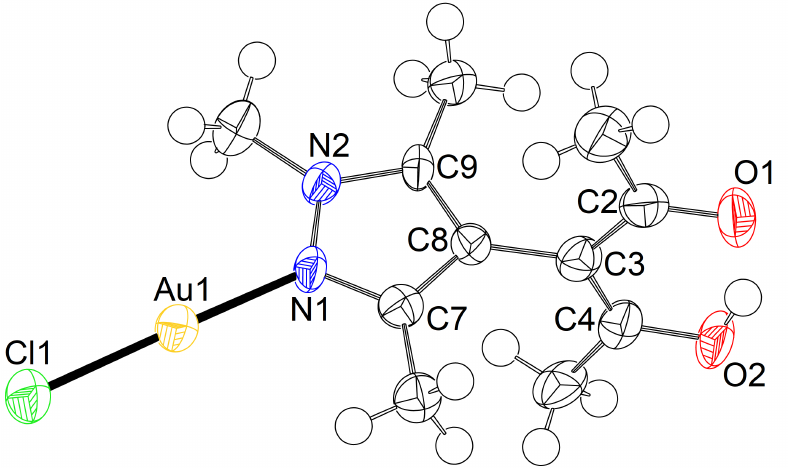
Figure 3. Displacement ellipsoid plot [33] of 2 (90% probability). Selected intramolecular distances and angles (Å, °): Au1–Cl1 2.2446(13), Au1–N1 2.011(4), Cl1–Au1–N1 178.15(12), ω